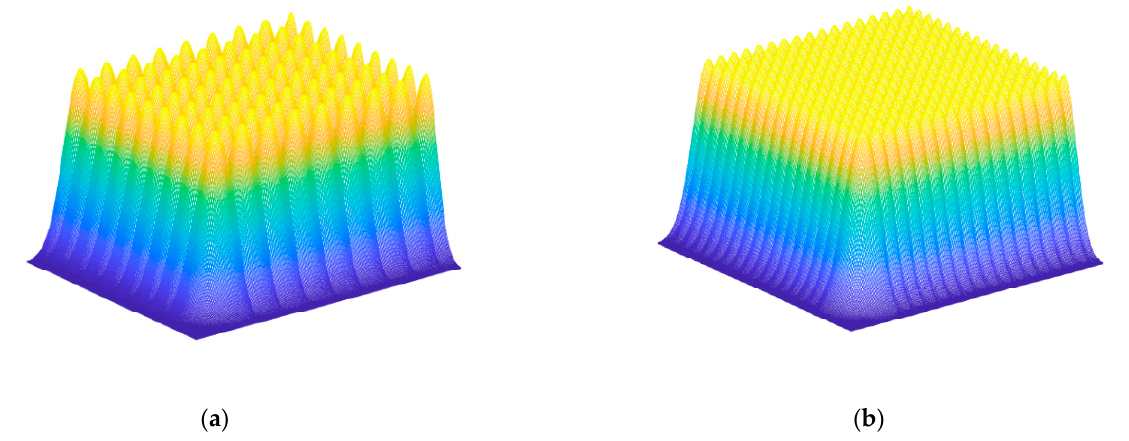
Figure 2. Simulation of surface topography after scanning with different pulse density: ( a ) Low pulse density ( b ) High pulse density